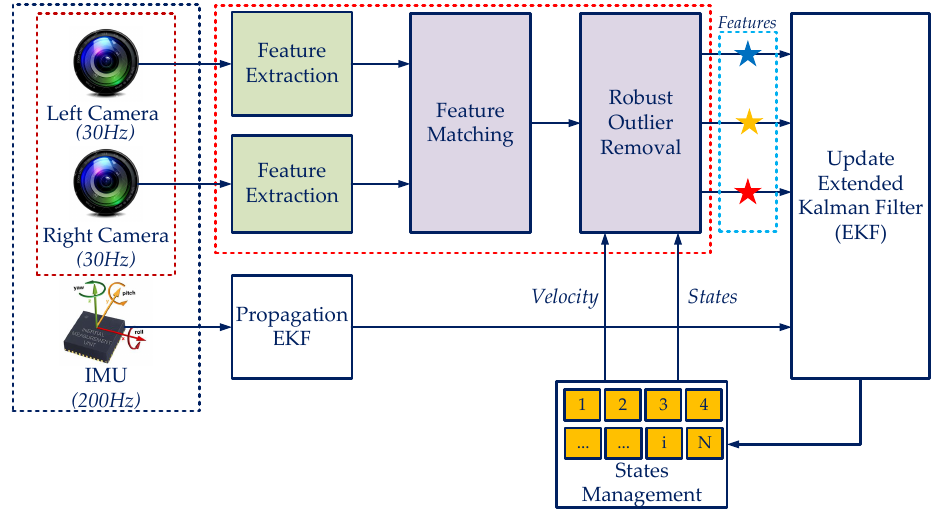
Figure 2. The proposed navigation system architecture is based on a robust visual-inertial fusion with a multi-stage outlier removal. Herein, the features are classified into three classes which are represented by blue, yellow, and